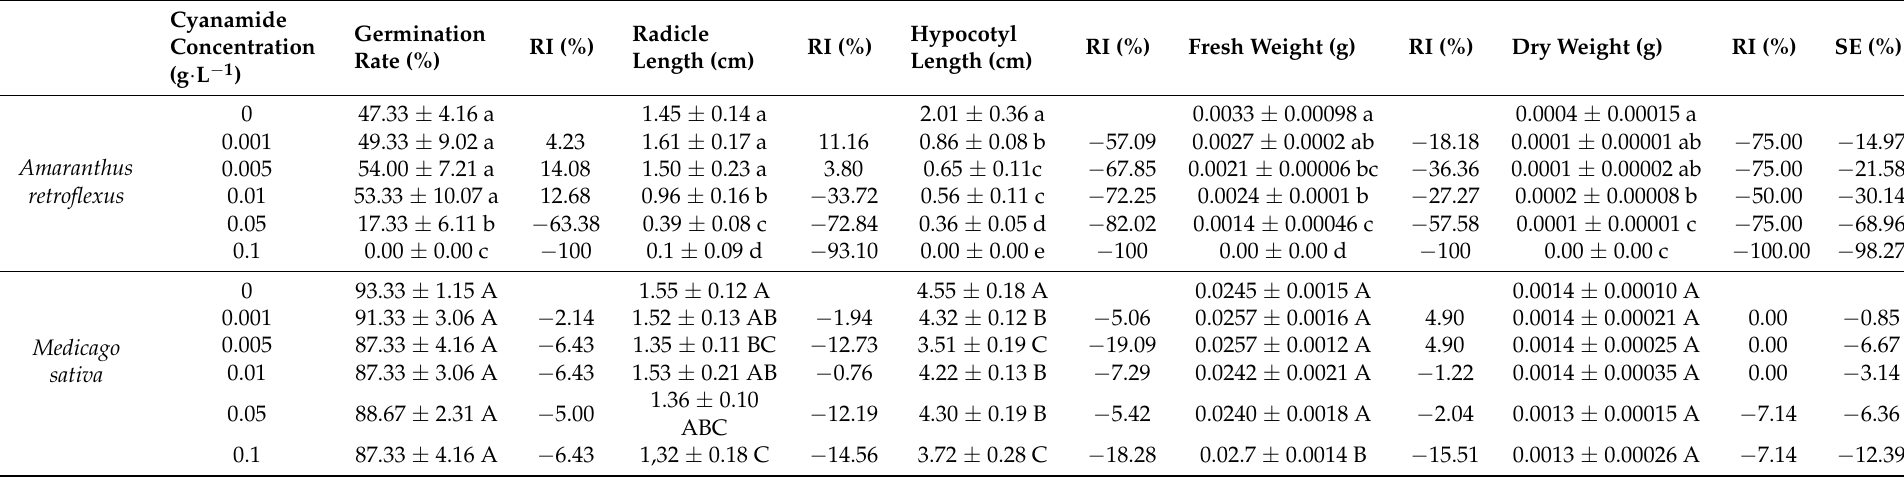
Table 1. Phytotoxic effect of cyanamide on seed germination of alfalfa and amaranth at different concentration (0, 0.001, 0.005, 0.01, 0.05, and 0.1 g · L − 1 ). Different lower-case letters in columns indicate significant differences among treatments of amaranth at p < 0.05 (LSD test). Different capital letters in columns indicate significant differences among treatments of alfalfa at p < 0.05 (LSD